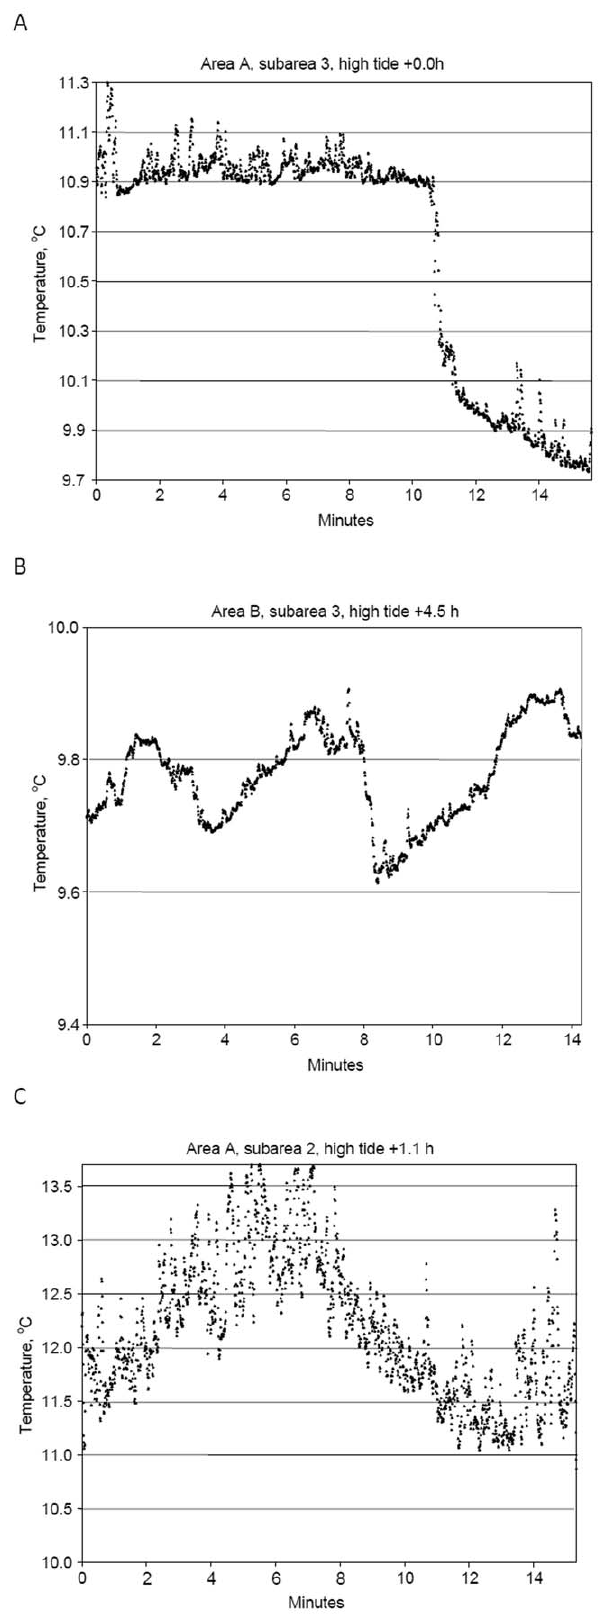
Figure 10. Rapid temperature changes in CTD temperature data collected along Seaboss video drift tracks. Examples of rapid temperature changes within the tidal front in off-bank subareas. A. Single rapid temperature changes (up to 0.6 u C); sta. 908047, 801 m drift. B. Multiple rapid (4–5 min duration) saw tooth fluctuations (up to 0.3 u C); sta. 908024, 498 m drift. C. Multiple rapid (6 min duration) saw tooth temperature fluctuations (up to 2–3 u C); sta. 908034, 812 m